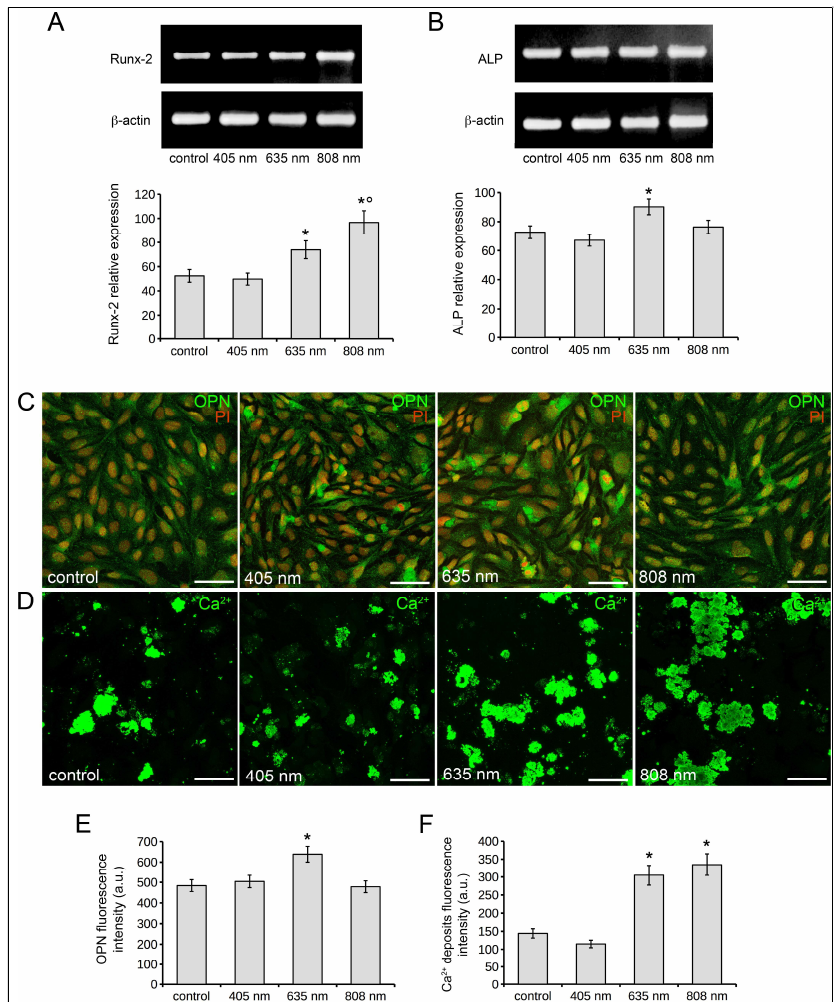
Figure 3. Effects of red (635 nm), NIR (808 nm) and violet-blue (405 nm) PBM on osteoblast differentiation. Osteoblasts subjected or not (control) to PBM treatments with 635 nm, 808 nm or 405 nm as reported in Table 1, were cultured for 7 and 18 days in osteogenic DM. ( A , B ) RT-PCR analysis of ( A ) Runx-2 and ( B ) ALP expression in the cells cultured for 7 days in DM in the indicated experimental conditions. Representative agarose gels are shown. The densitometric analyses of the bands normalized to β-actin are reported in the histograms. ( C , D ) Representative confocal fluorescence images of cells cultured in DM in the indicated experimental conditions. In ( C ) the cells were cultured for 7 days, fixed and immunostained with antibodies against osteopontin (OPN, green) and stained with PI (red) to reveal nuclei. In ( D ) the cells were cultured for 18 days, fixed and stained with the fluorescent Osteolmage™ staining reagent (green) binding the hydroxyapatite portion of the bone like nodule structures deposited by cells (Ca 2+ deposits). Scale bar: 50 µm. ( E , F ) Histograms showing the densitometric analyses of the intensity of ( E ) OPN and ( F ) Ca 2+ deposits fluorescence signals performed on digitized images. The data are representative of at least three independent experiments, performed in triplicate. The values are expressed as mean ± S.E.M. Significance of difference: * p < 0.05 vs. control, ° p < 0.05 vs. 635 nm.